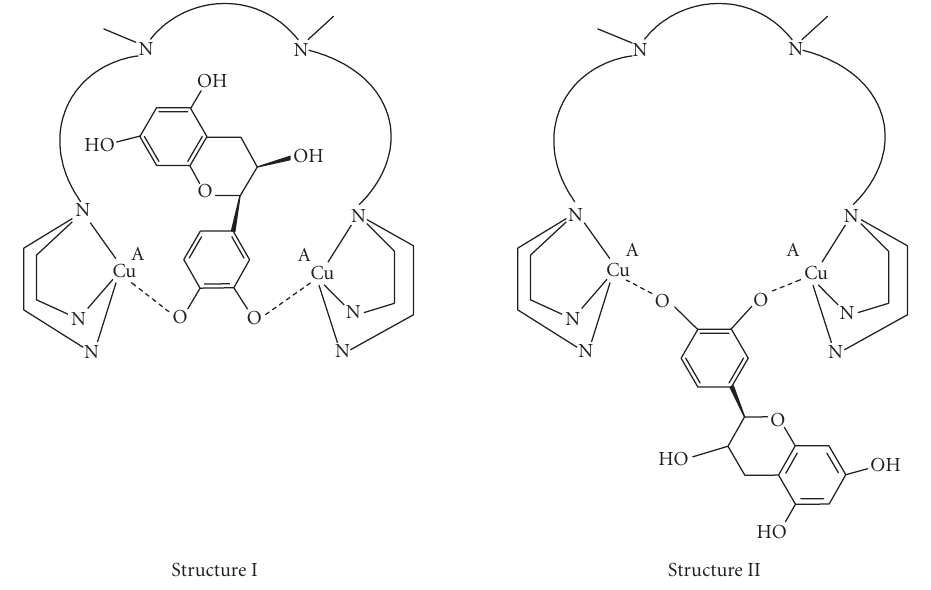
Scheme 2: Proposed structures for the putative intermediate adducts formed by the dinuclear copper(II) complexes in the catalytic oxidations of the catechins.